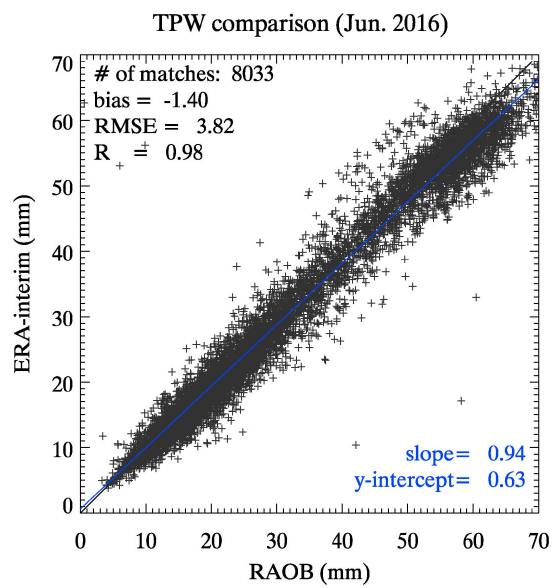
Figure 11. Comparisons of TPW from two different reference data (Radiosonde vs. ERA-interim) for June